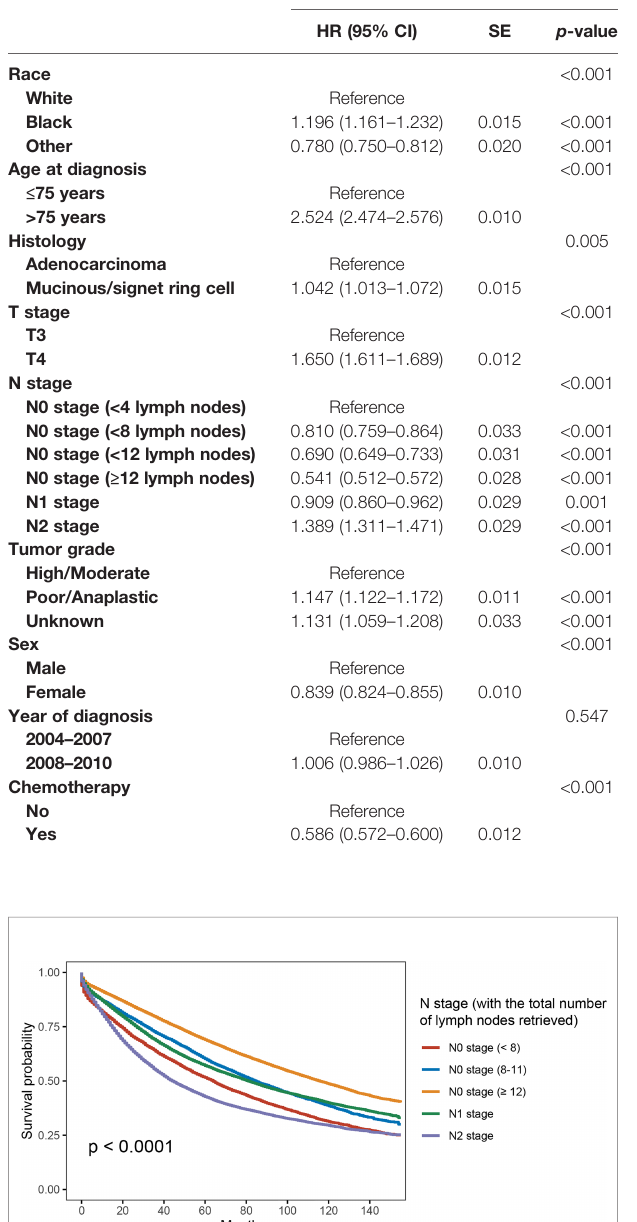
TABLE 3 | Multivariate analyses on overall survival in colon cancer (with the combination of less than four lymph nodes and less than eight lymph nodes retrieved